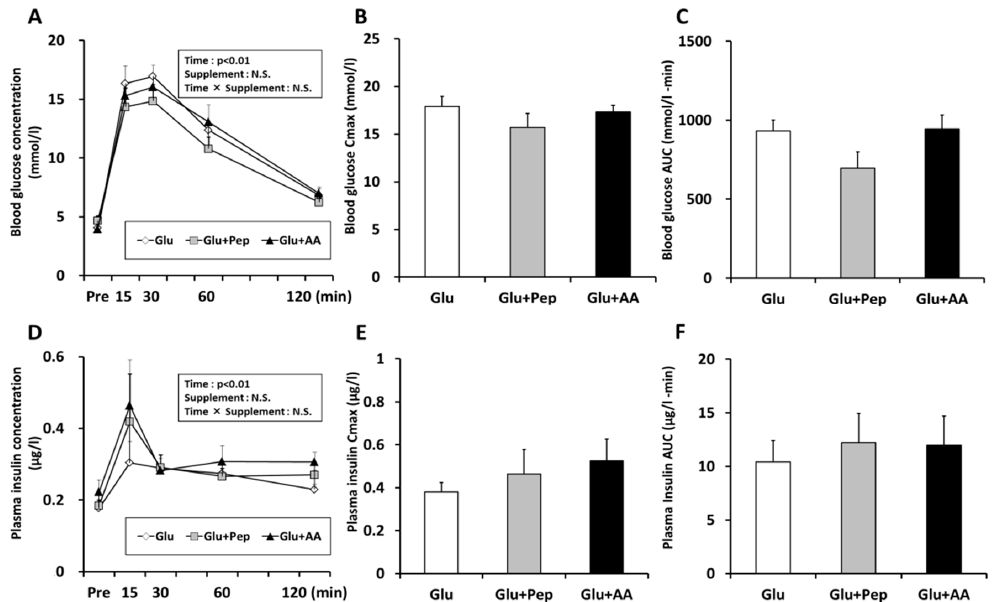
Figure 3. Blood substrate concentration. ( A ) Blood glucose concentration; ( B ) Blood glucose Cmax; ( C ) Blood glucose AUC; ( D ) Plasma insulin concentration; ( E ) Plasma insulin Cmax; ( F ) Plasma insulin AUC. Values are presented as mean ± SEM.